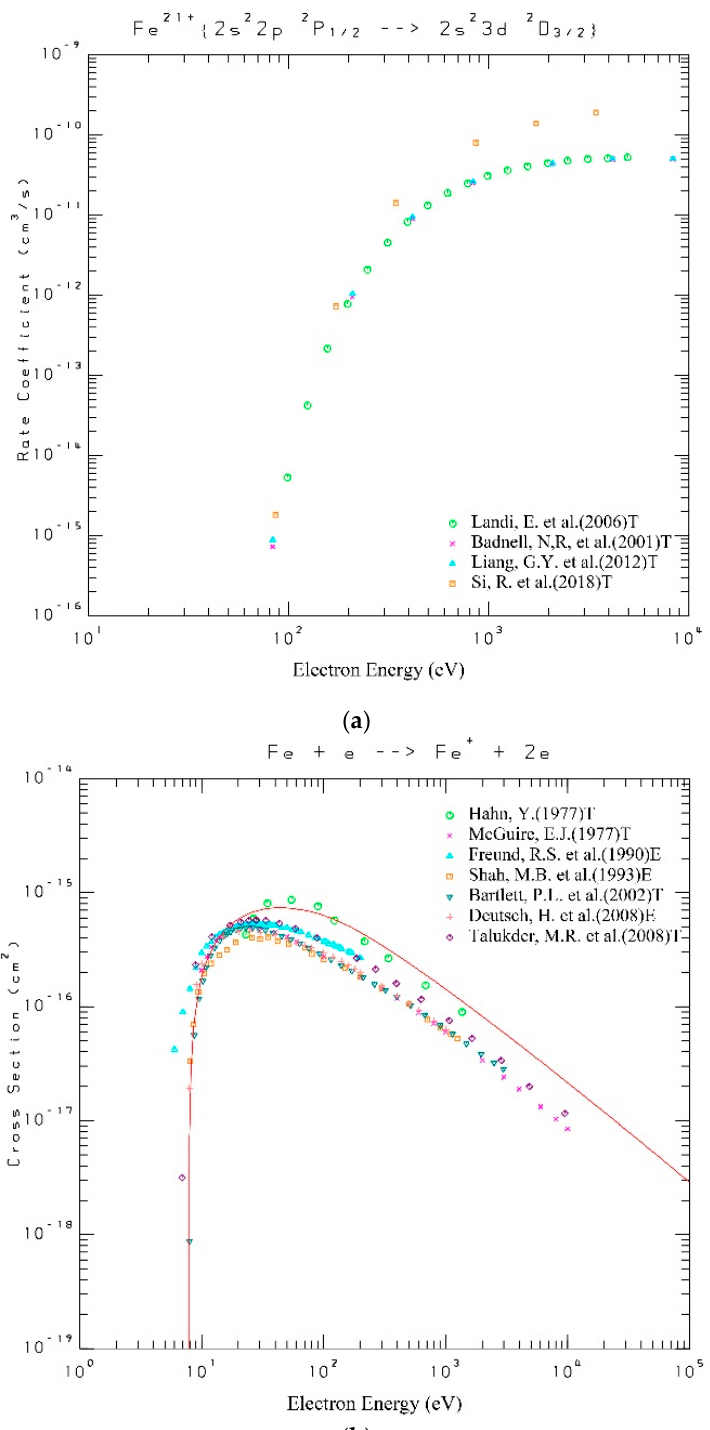
the validity. Three data sets calculated with R-matrix method [22–24] agree with each other, and one calculated with distorted wave method by Si et al. [25] shows larger values than others.